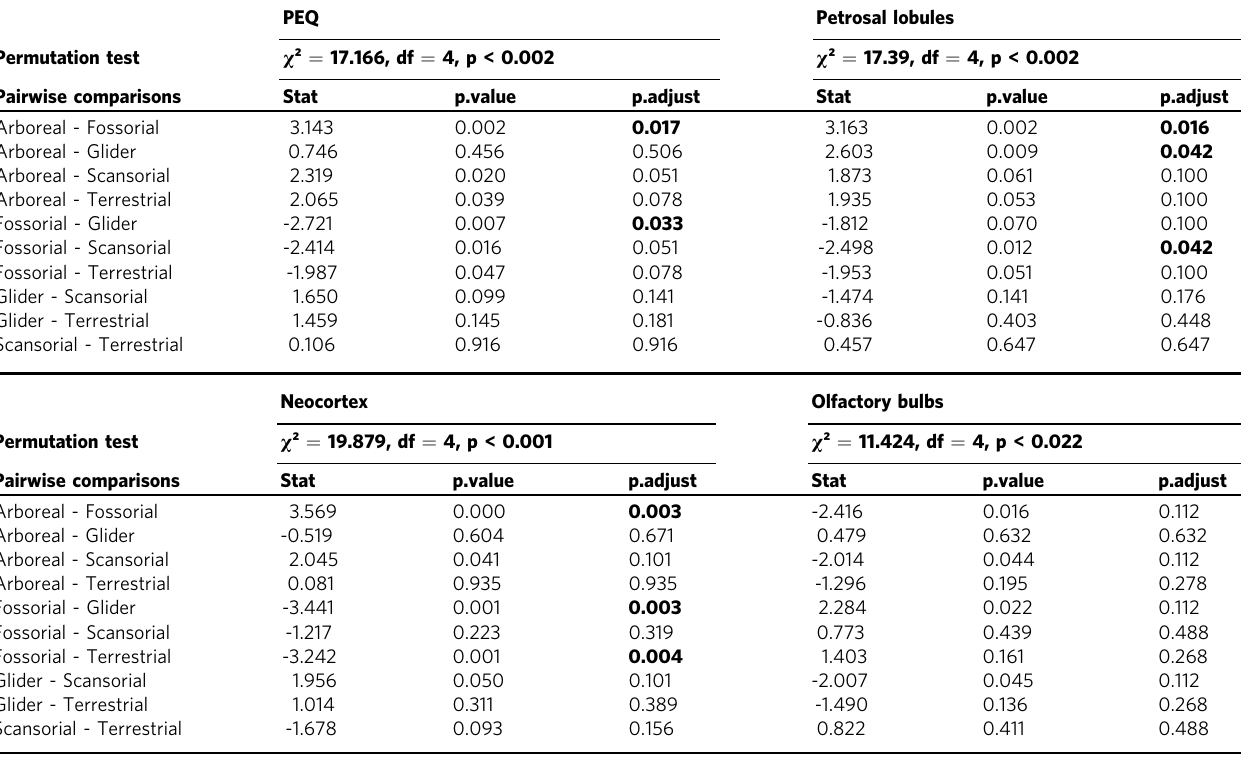
Table 1 . Locomotion permutation test and pairwise comparisons performed on the Phylogenetic Quotient (PEQ) and brain regions in Sciuroidea. PEQ Petrosal lobules Permutation